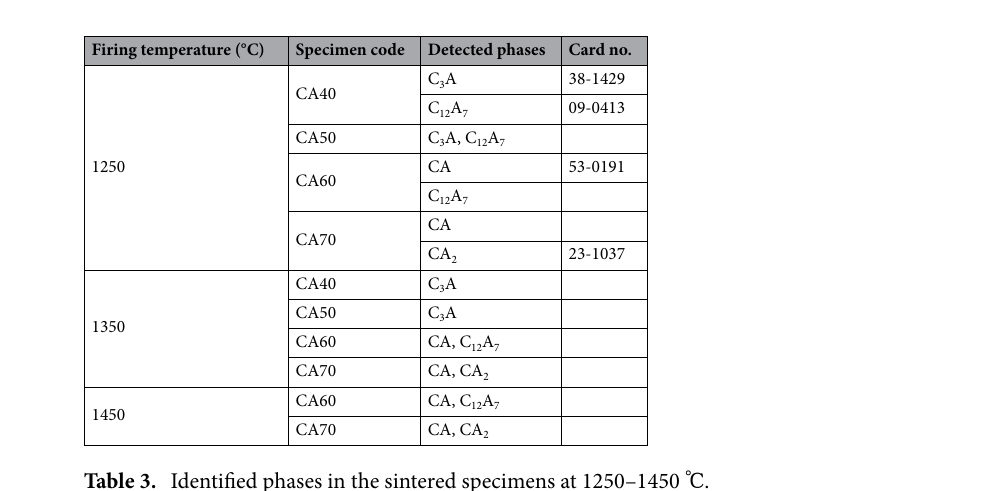
Table 3. Identified phases in the sintered specimens at 1250–1450 ℃ .